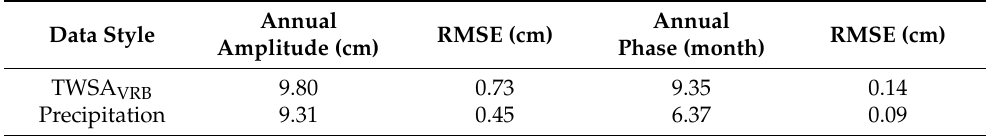
Figure 2. Monthly changes of GRACE-derived TWSA VFL and TWSA VRB , respectively, over Volta Frac- tured Land and Volta River Basin, and Annual precipitation changes within the basin from 2002 to 2020. Volta Fractured Land represents the Lake Volta and Bui reservoir catchment. Table 1. Annual Amplitude and Phase of TWSA VRB and